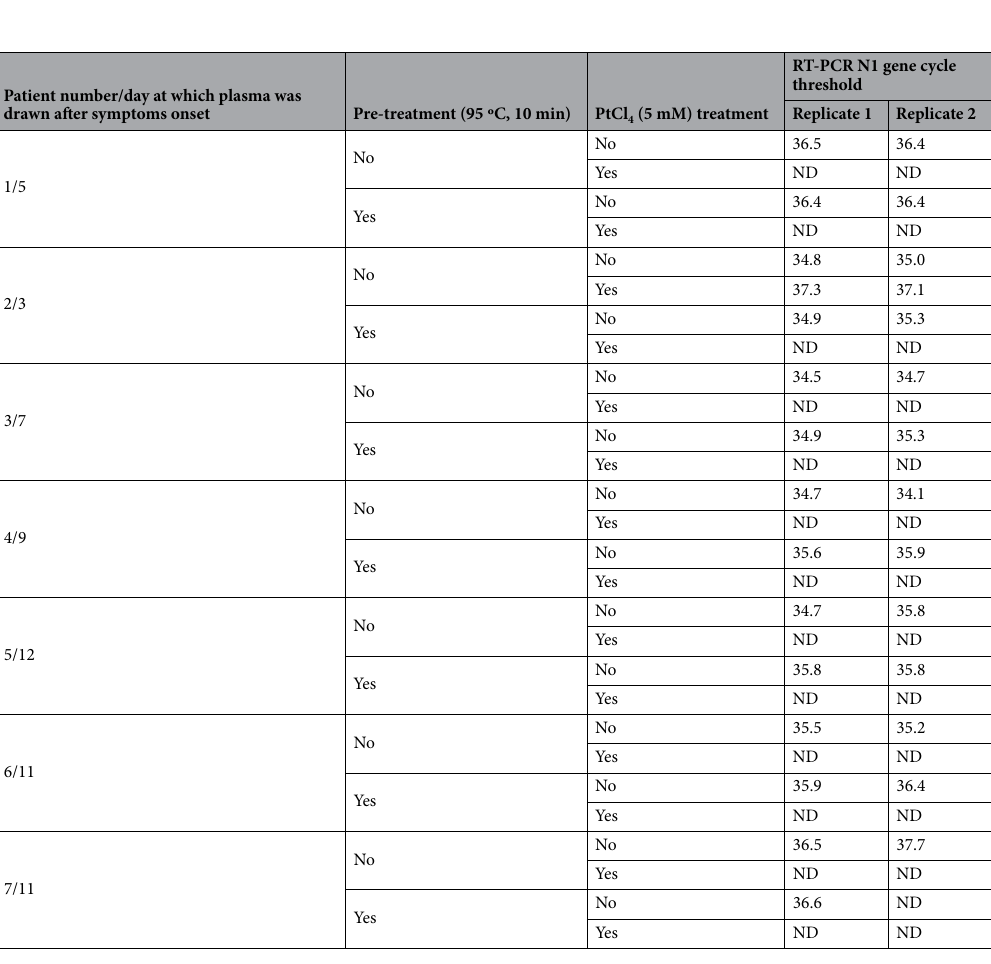
Table 3. RT-PCR viability assay performed with plasma from unique intensive care unit patients. ND not detected.